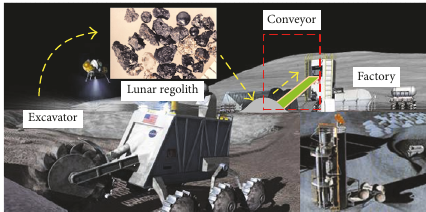
Figure 1: Conception of lunar regolith excavation and conveyance to establish a lunar base